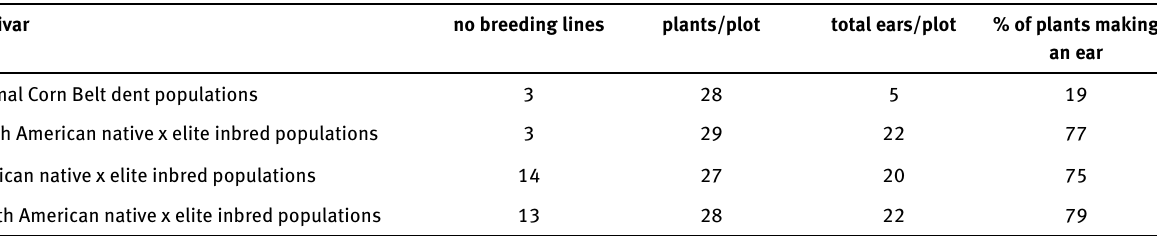
Table 6: Comparison of ear production by top 30 breeding lines and 3 normal Corn Belt Dent checks when grown on a Metea sandy loam without fertilization near Eagle, Wisconsin in 2013